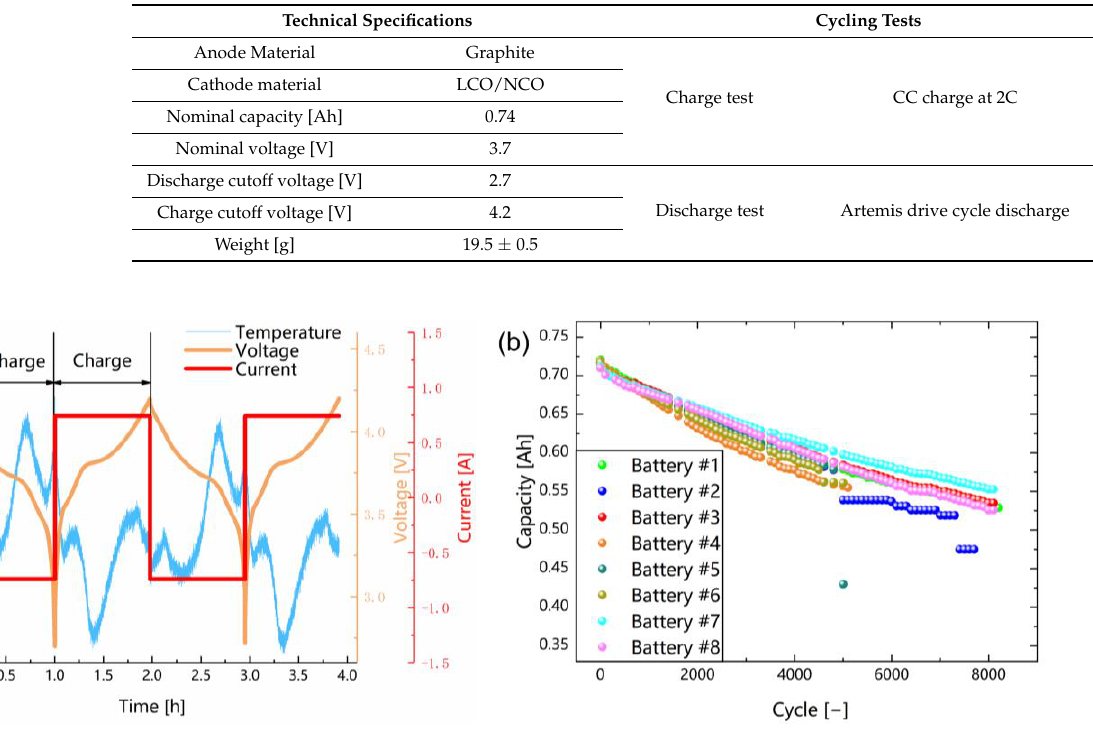
Figure 1. Battery aging cycle schemes and capacity degradation profiles. ( a ) Completed aging cycle test for voltage, current and temperature. ( b ) Battery capacity degradation curves of the eight bat- teries. Table 1. Technical specifications and battery test procedures of the eight batteries.